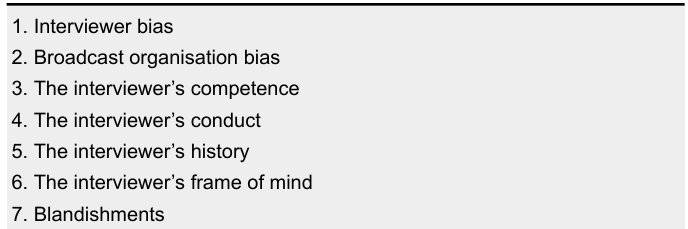
Categories of Personalisation. Equivocal Responses Directed Personally